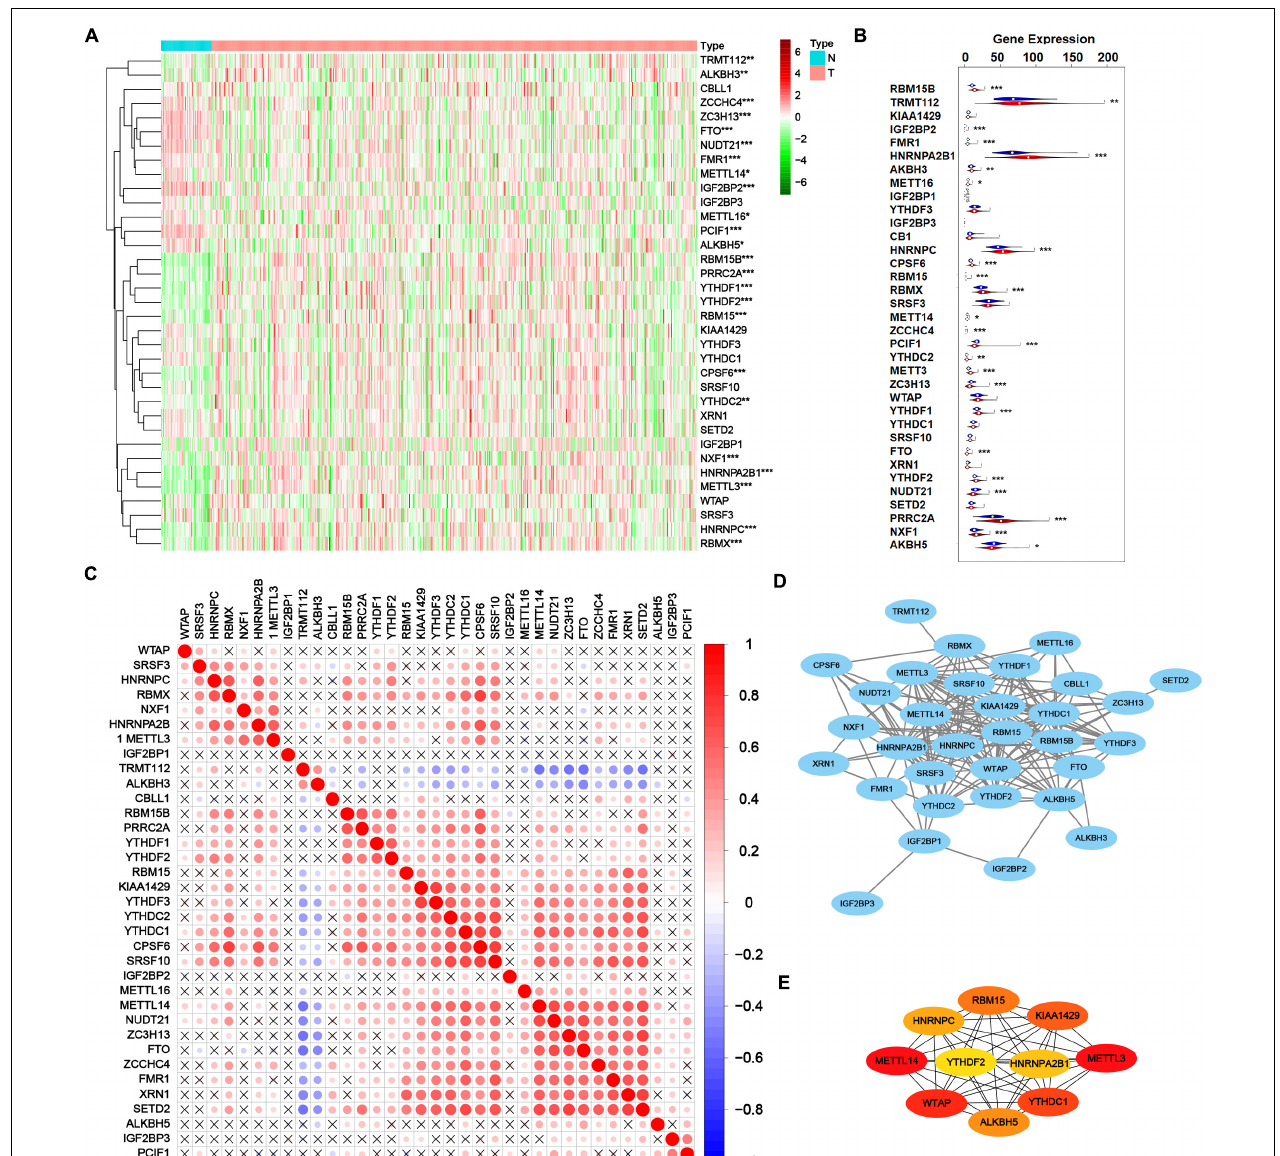
FIGURE 2 | Transcriptome profiles of m 6 A RNA methylation regulators in prostate adenocarcinoma. (A,B) The differential expression of m 6 A related genes between 499 tumorous tissues and 52 normal tissues in TCGA-PRAD cohort. (C) The correlation of the m 6 A regulatory genes. (D) Protein-protein interaction (PPI) network of m 6 A regulatory genes. Elements not connected to other genes are hidden. (E) PPI network of top 10 pivotal genes from all m 6 A regulatory genes obtained by CytoHubba plugin of Cytoscape.